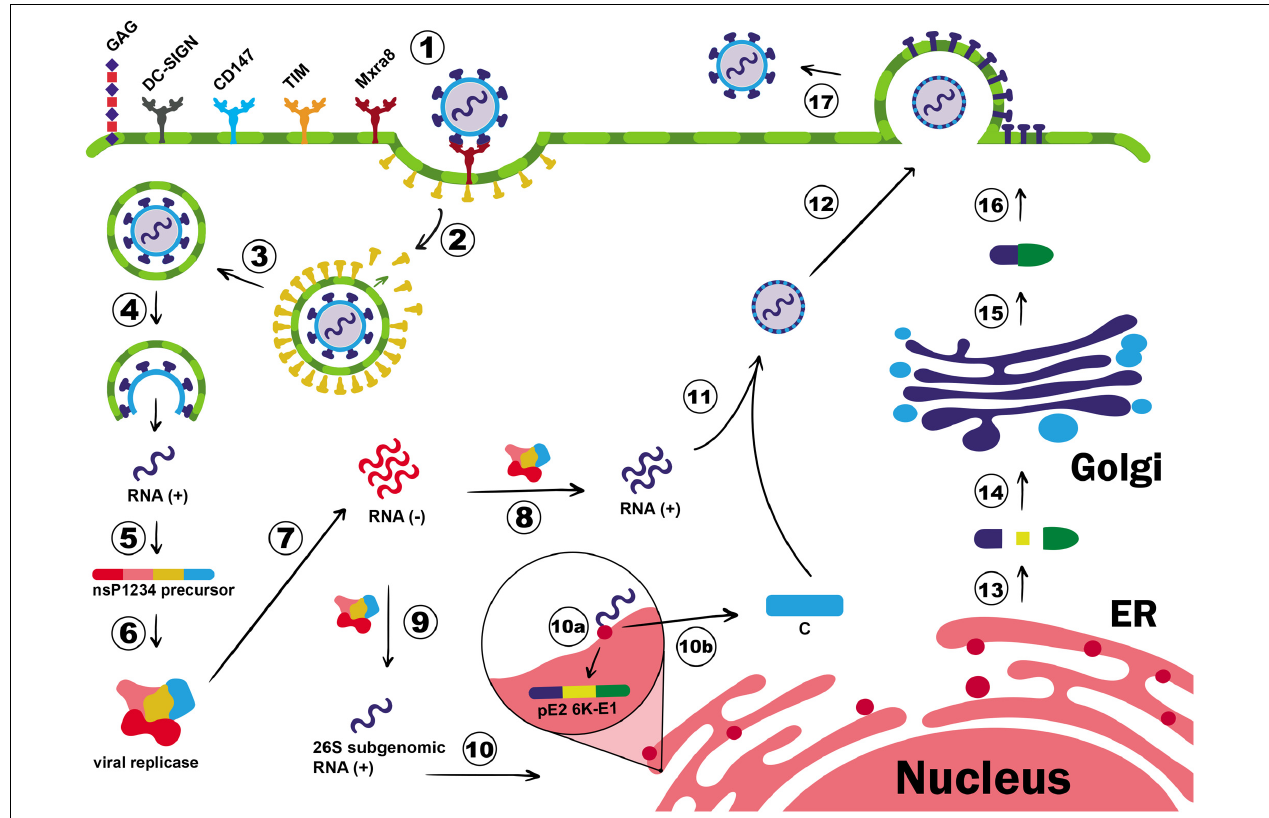
FIGURE 1 | Chikungunya virus (CHIKV) cell entry and replication. E2 glycoprotein binds to the membrane receptor Mxra8, inducing the translocation of clathrin molecules to the plasma membrane (1). GAG, DC-SIGN, CD147, and TIM are also described as CHIKV co-receptors, but their role for entry process is not well elucidated. CHIKV entry occurs via clathrin-mediated endocytosis pathway (2) and once the early endosome is formed, clathrin molecules dissociate from the endocytic vesicle (3), and the endosome proceed in the endocytic pathway. The pH acidification of endocytic vesicles triggers the detachment of E1-E2 heterodimers, exposing the fusion loop, which will culminate in the fusion of the endosomal with the viral membranes (4). Then, the nucleocapsid is released in the cytoplasm, genomic RNA is exposed, and translation of the non-structural polyprotein P1234 will take place (5). The P1234 protein is thus cleaved by the viral protease nsP2, releasing the individual non-structural proteins, which will form the viral replicase complex (6). The replicase complex is responsible for the synthesis of the negative-strand RNA (7) that will be the template for new positive-strand RNA (8) as well as for the synthesis of 26S subgenomic RNA (9). The subgenomic RNA, in its turn, is translated into the structural polyprotein C-pE2-6K-E1 in the rough endoplasmic reticulum (RER) (10). The C protein, which contains a protease domain responsible for its self-cleavage, dissociates from the polyprotein just after its translation (10b) and will attach to the positive polarity genomic RNA to form the nucleocapsid in the cytoplasm (11). In this meantime, the pE2-6K-E1 precursor will be addressed to the lumen of the ER (10a), where its maturation process will take place (13). The structural proteins will proceed in the exocytic pathway (14), until the end of E1-E2 heterodimers is mature (15). E1-E2 dimers will be deposited in the cell membrane forming the ‘virus budding microdomain’, a membrane domain where the budding process will occur (16). The recently assembled nucleocapsid migrates to this region, and new virions will be released to the extracellular milieu by budding